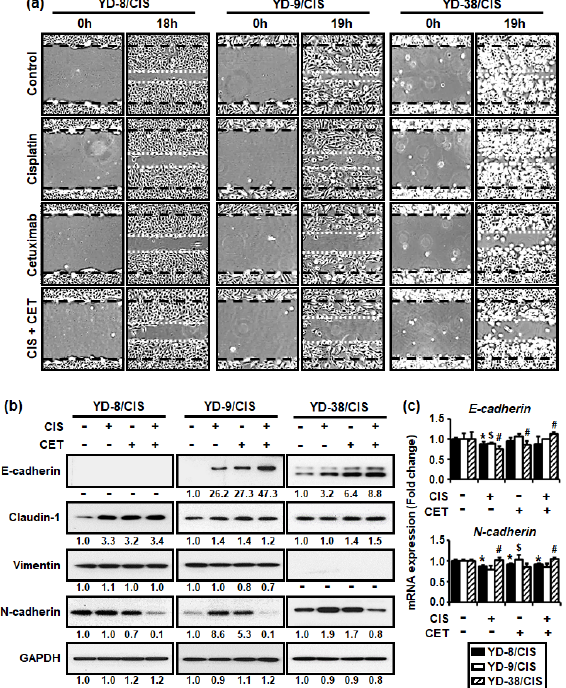
Figure 4. Cisplatin (CIS) (1 µ g/mL) and cetuximab (CET) (200 µ g/mL) co-treatment promoted greater reduction in cell motility and N-cadherin expression in cisplatin-resistant OSCC cells compared to each alone. However, co-treatment promoted the expression of E-cadherin, which is known to be involved in cell adhesion. ( a ) Cell migration was analyzed using in vitro scratch assay, whereas images were obtained using an Olympus CKX53 inverted microscope ( × 40). ( b ) The levels of EMT signaling pathway proteins (E-cadherin, claudin-1, vimentin, and N-cadherin) and GAPDH in cell lysates from all three cell lines treated with cisplatin and/or cetuximab for 48 h were determined using the Western blot assay. Western blot results were quantified using Image J software. The numbers represent the ratio of the optical density of cisplatin and/or cetuximab-treated to non- treated cells normalized by GAPDH. ( c ) The expressions of E-cadherin and N-cadherin mRNA from all three cell lines treated with cisplatin and/or cetuximab for 24 h were determined using real-time qRT-PCR (mean ± SD; n = 3). * p < 0.05 versus non-treated group in YD-8/CIS cells, # p < 0.05 versus non-treated group in YD-9/CIS cells, and $ p < 0.05 versus non-treated group in YD-38/CIS